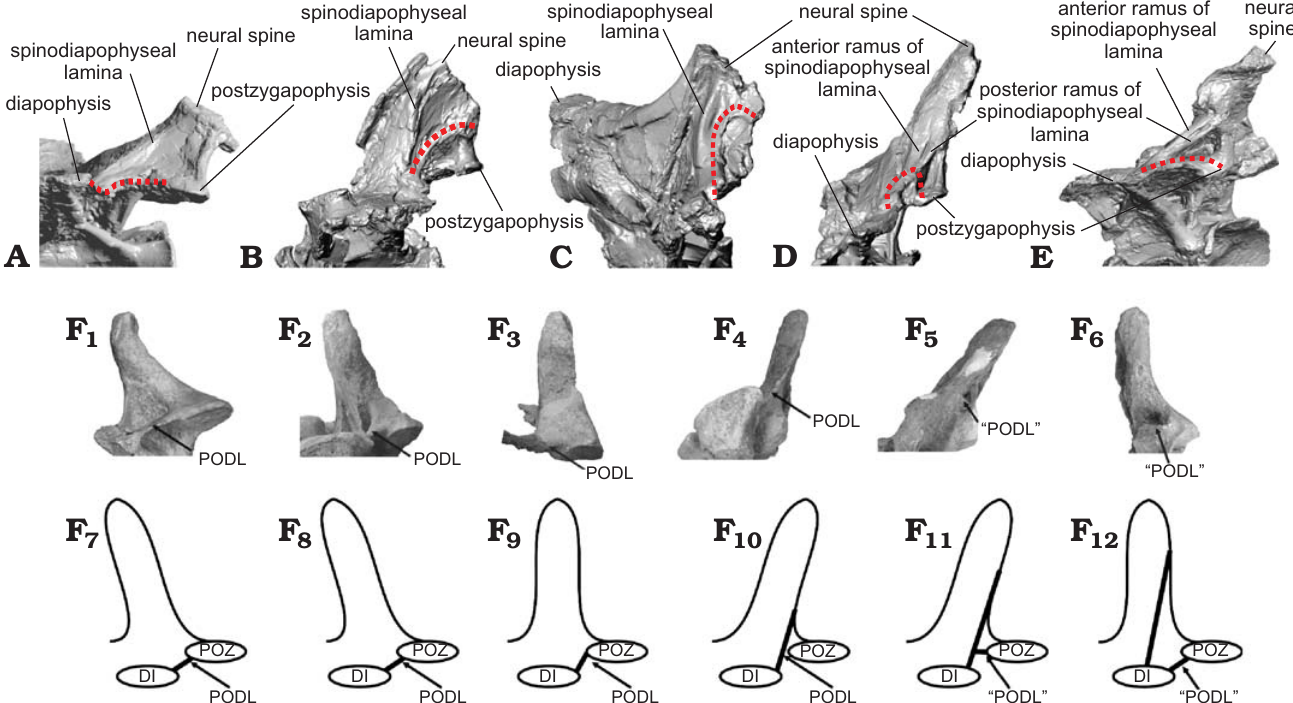
Fig. 5. Comparison of lamina capture in dorsal vertebrae of titanosaurian sauropod Dreadnoughtus schrani Lacovara, Lamanna, Ibiricu, Poole, Schroeter, Ullmann, Voegele, Boles, Carter, Fowler, Egerton, Moyer, Coughenour, Schein, Harris, Martínez, and Novas, 2014, from Santa Cruz Province, Argentina; middle–late Campanian to early Maastrichtian (A–E, shown in non-standard views for best visualization) and “disconnection” (sensu Gallina 2011) in presacral vertebrae of Bonitasaura salgadoi Apesteguía, 2004 from Río Negro Province, Argentina; Santonian (F). A . Left side of MPM-PV 1156?-4, estimated as the ~4 th dorsal vertebra. B . Left side of MPM-PV 1156?-5, ~5 th . C . Right side of MPM-PV 1156-6 (mirrored), ~6 th . D . Right side of MPM-PV 1156?-8 (mirrored), ~7 th . E . Right side of MPM-PV 1156?-9 (mirrored), ~8 th . Changes in the PODLs through the sequence are denoted by a dotted